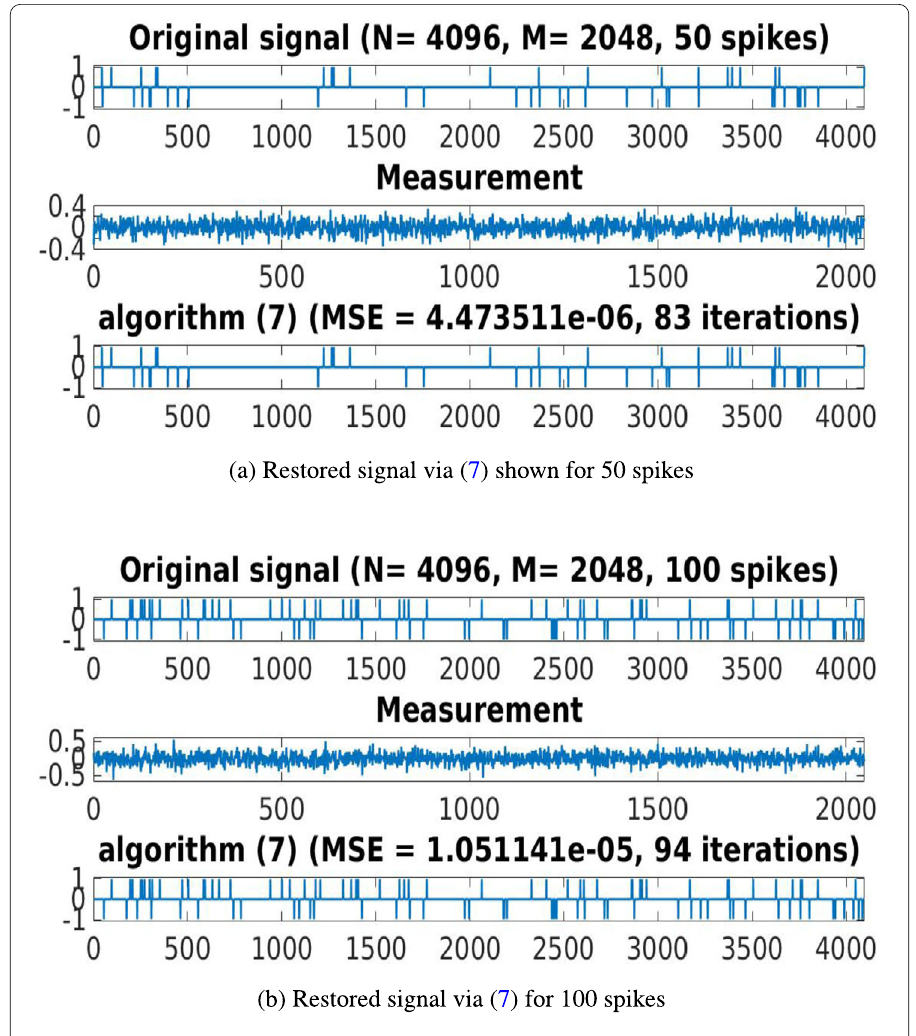
Figure 7 Restored signal via algorithm